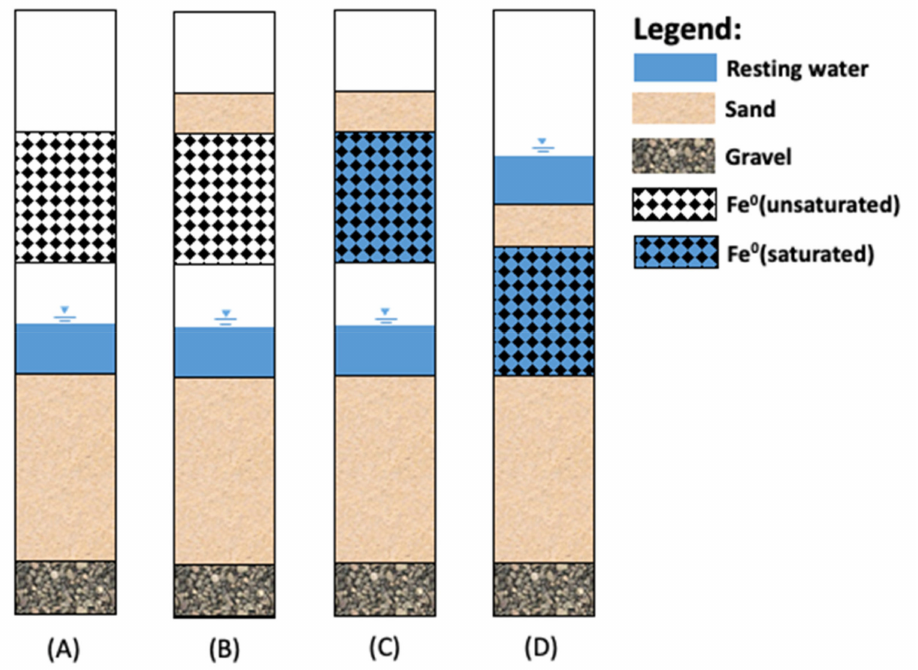
Figure 2. Diagram showing the set-up of the original Kanchan arsenic filter (KAF) and three different possible modifications. ( A ) represents the original KAF, ( B , C ) the modifications tested by Mueller [1,2], ( D ) represents one modification tested by Bretzler et al. [11] and Smith et al.